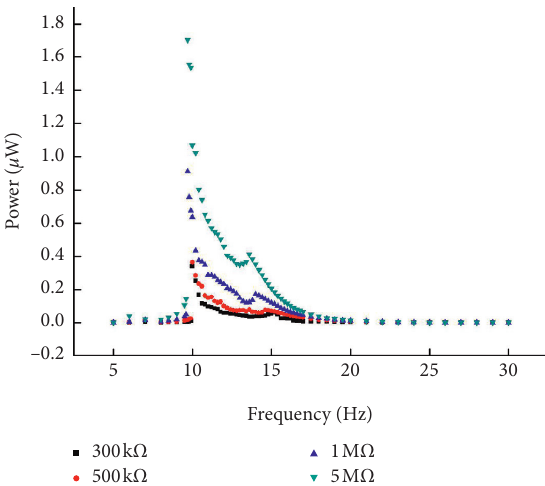
Figure 30: Relation of the power-frequency of the system is given when external loads are selected as 300k Ω , 500k Ω , 1 M Ω , and 5 M Ω ,